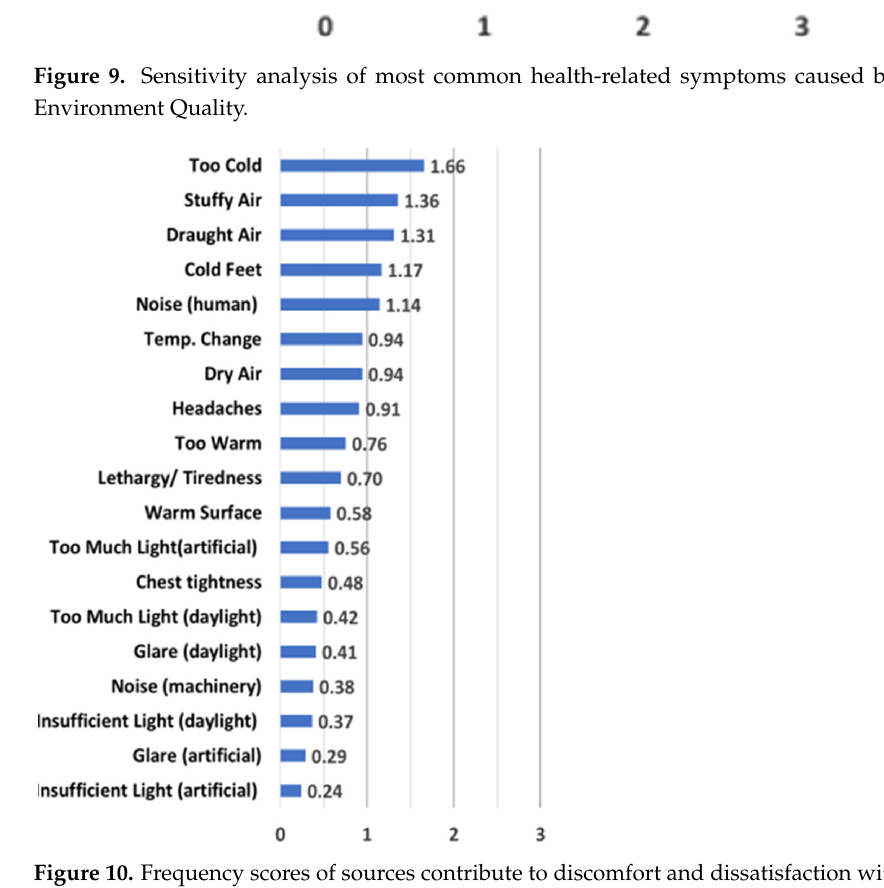
Figure 10. Frequency scores of sources contribute to discomfort and dissatisfaction with IEQ.